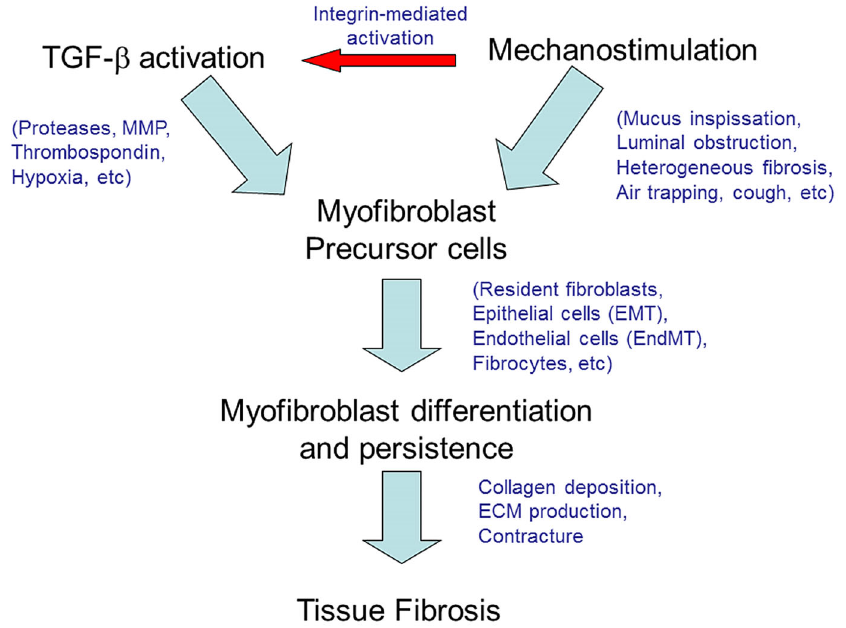
Figure 5. Schematic model depicting myofibroblast differentiation in cystic fibrosis (CF). TGF- b signaling and mechanostimulation in CF lungs induce precursor cells such as resident fibroblasts to undergo myofibroblast differentiation. TGF- b activation is robust and likely multifactorial due to well-established mechanisms including integrin expression and proteases such as the matrix metalloproteases (MMPs). Mechanical strain (e.g. from luminal obstruction, tissue fibrosis and persistent coughing) further augments TGF- b activation and contributes to development and persistence of the myofibroblast phenotype. Sources of myofibroblast precursors include resident lung tissue fibroblasts, circulating fibrocytes, epithelial mesenchymal transition (EMT) or endothelial mesenchymal transition (EndMT). Persistence of the myofibroblast leads to progressive tissue fibrosis with collagen production, extracellular matrix synthesis and tissue contracture.